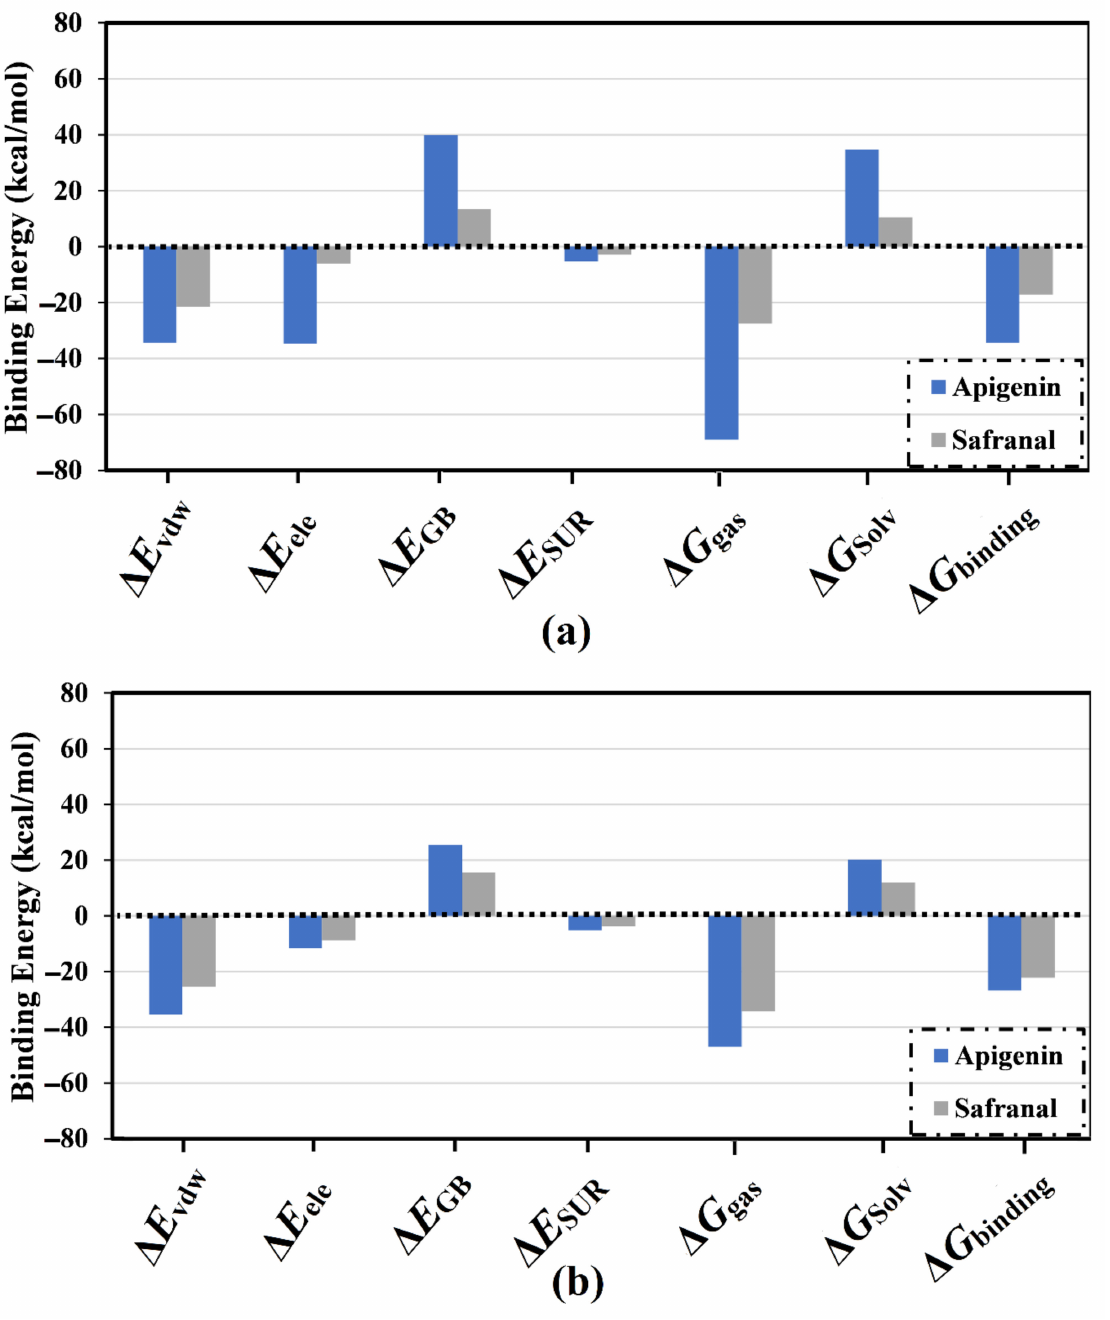
Figure 5. Participation of diverse energy components in the total MM-GBSA binding energies of apigenin and safranal complexed with ( a ) 5HT2A and ( b ) 5HT1A receptors. 2.3. Analysis of the Key Amino Acids Involved in Drug–Protein Interactions To identify the key amino acid residues of the 5HT2AR and 5HT1AR that were primar- ily involved in the interaction with apigenin and safranal, per residue decomposition of the binding affinity was carried out. All the amino acid residues with energetic participation < − 0.50 kcal/mol were selected (Figure 6). The VAL156, LEU228, and LEU247 amino acid residues were the common residues of the 5HT2AR that interacted with both apigenin and safranal (Figure 6a). Similarly, the residues VAL117, ILE189, THR200, PHE 361, and PHE 362 were the common residues of the 5HT1AR that interacted with both apigenin and safranal (Figure